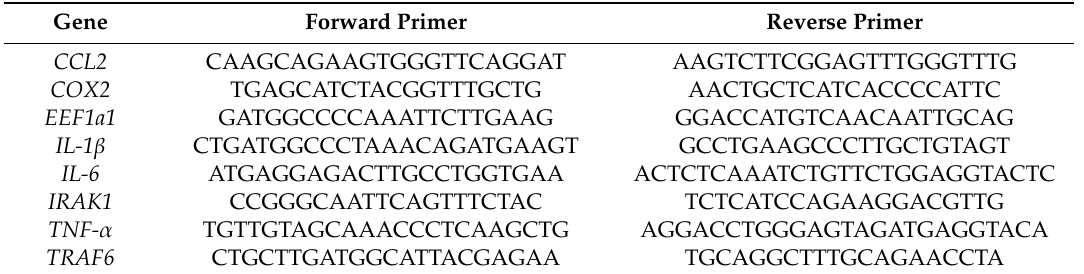
Table 1. Oligonucleotide sequences of primers used for quantitative